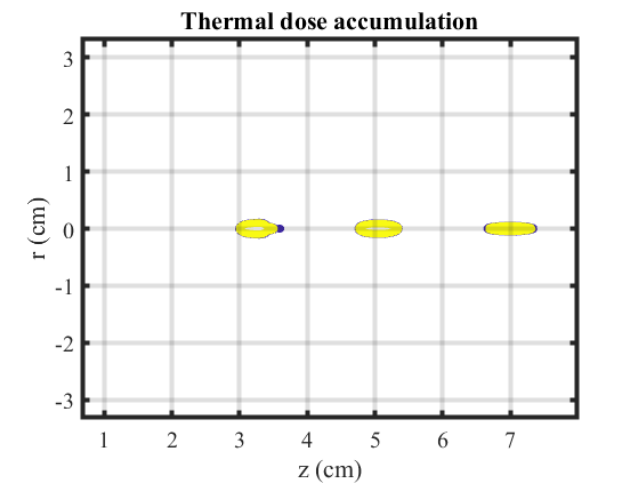
Figure 4. Visualization of the focal region generated by a bowl HIFU transducer and its variation with